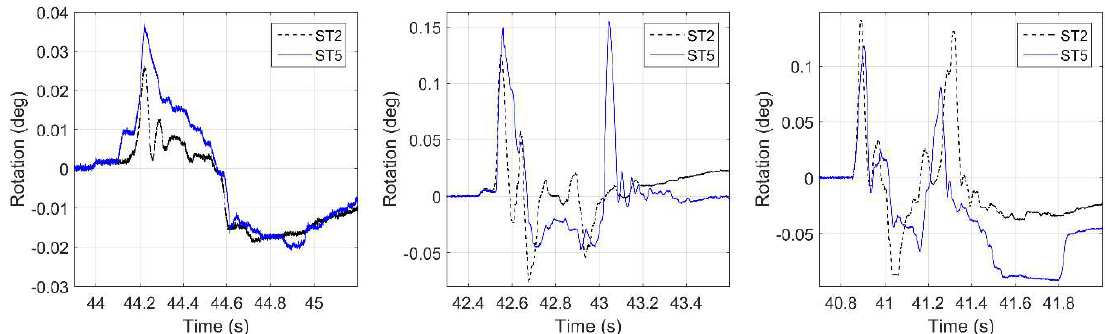
Figure 15. Time histories of cumulative rotation (deck angle), for three waves with H = 0.42 m ( left ), H = 0.55 ( middle ), and H = 0.90 m ( right ), and two deck types